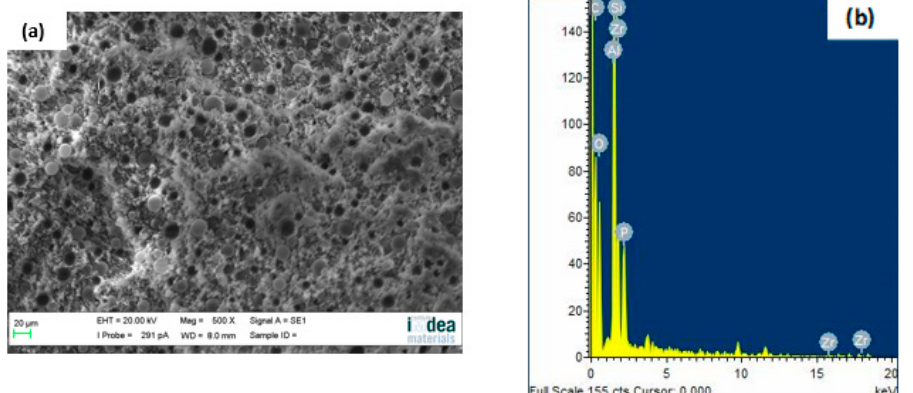
Figure 1. ( a ) Scanning electronic microscopy (SEM) image and ( b ) Energy dispersive X-Ray spectroscopy (EDS) spectrum of PP-4 .